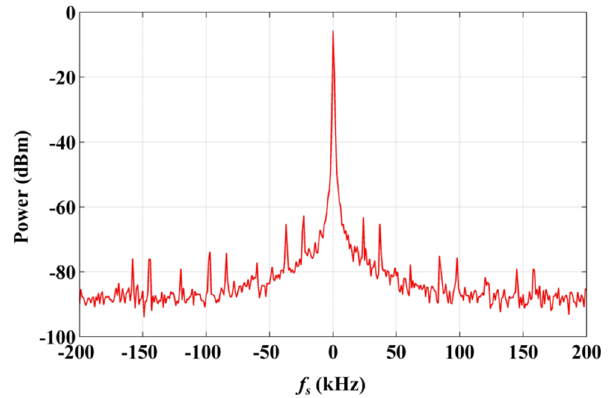
Figure 3. Spectrum of the signal of beat between the eigenfrequency laser (EFL) and the up-converted laser (UCL), acquired without using the optical phase-locked loop (OPLL).